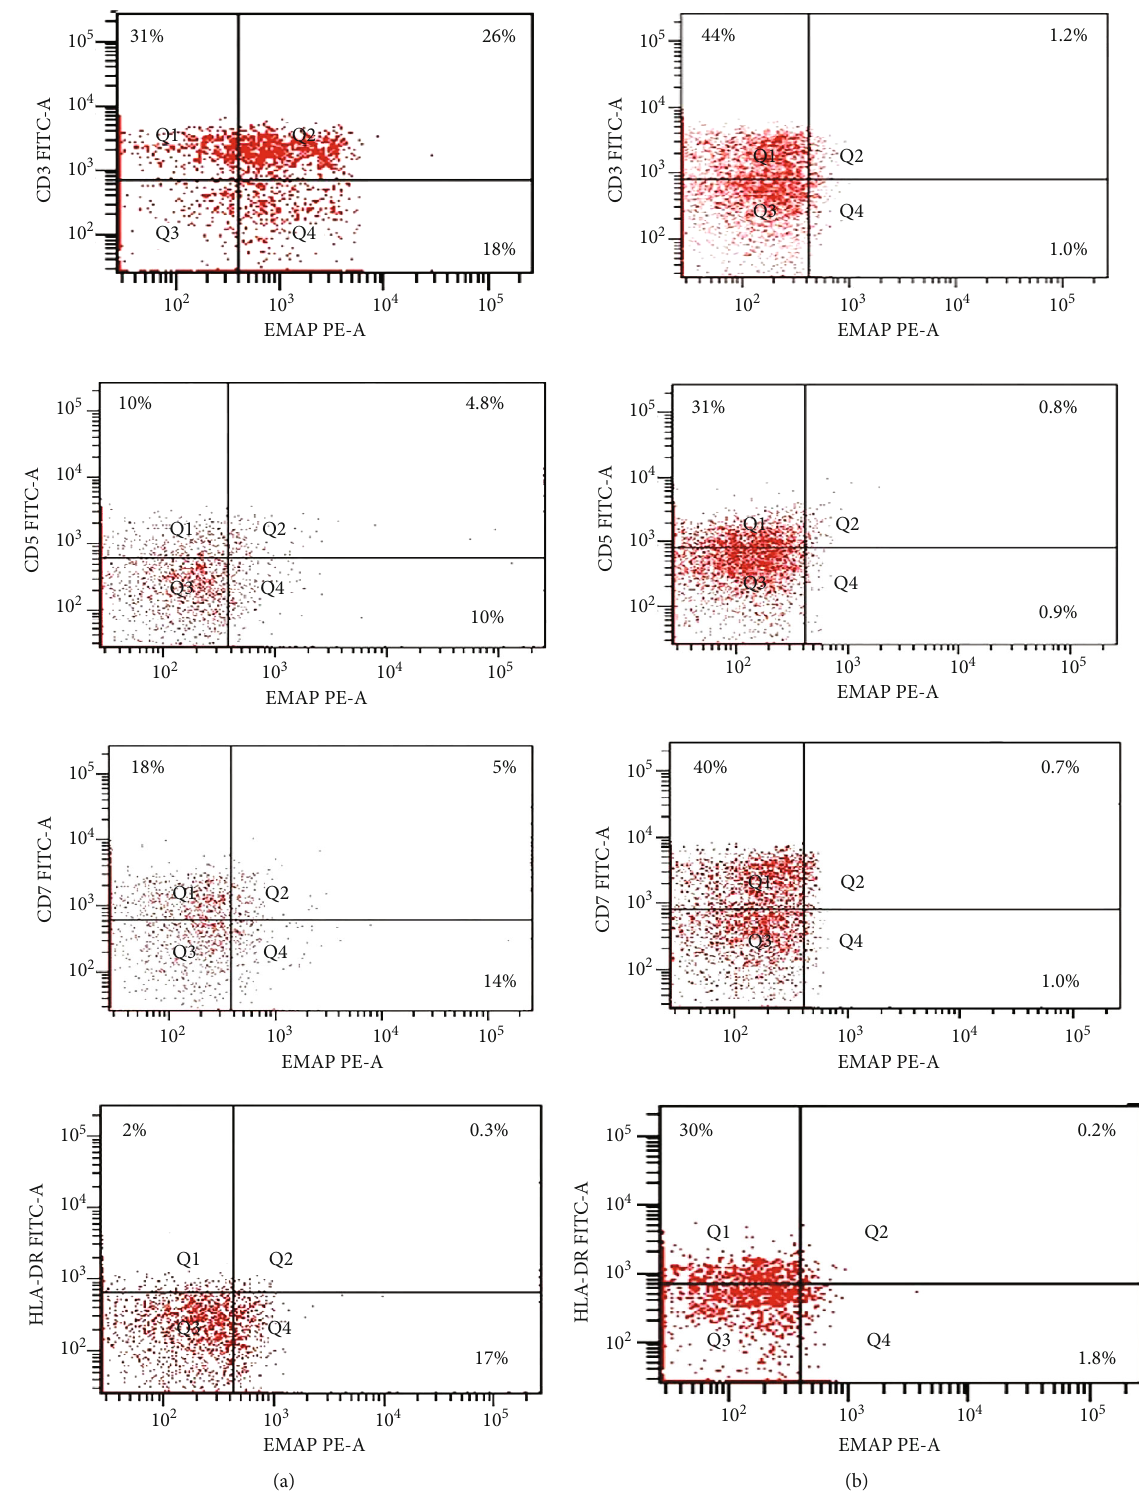
Figure 2: EMAP II expression in CD3, CD5, CD7, and HLA-DR cells: (a) newly diagnosed NHL patient; (b) representative fl ow cytometric dot plots of normal